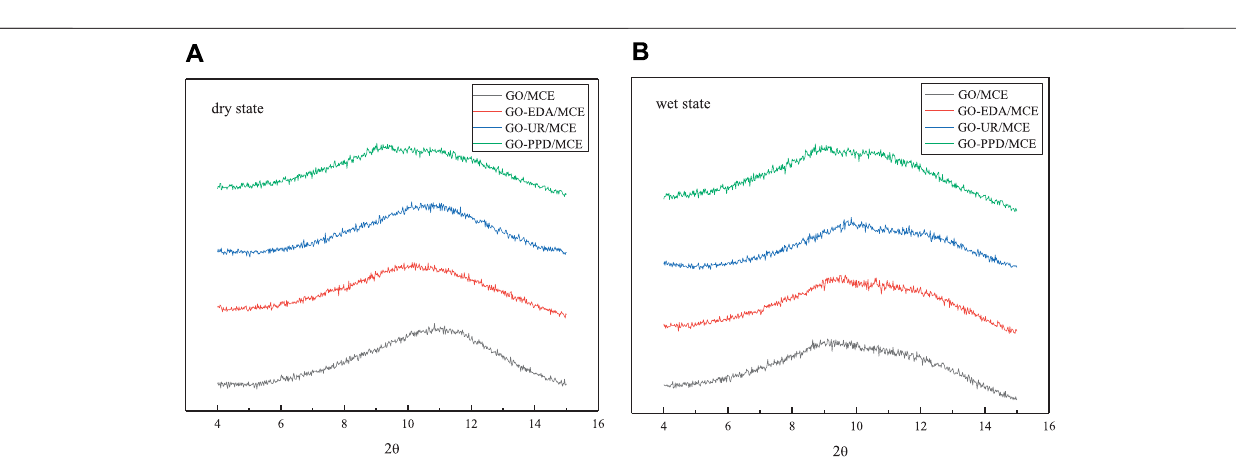
Frontiers in Chemistry |